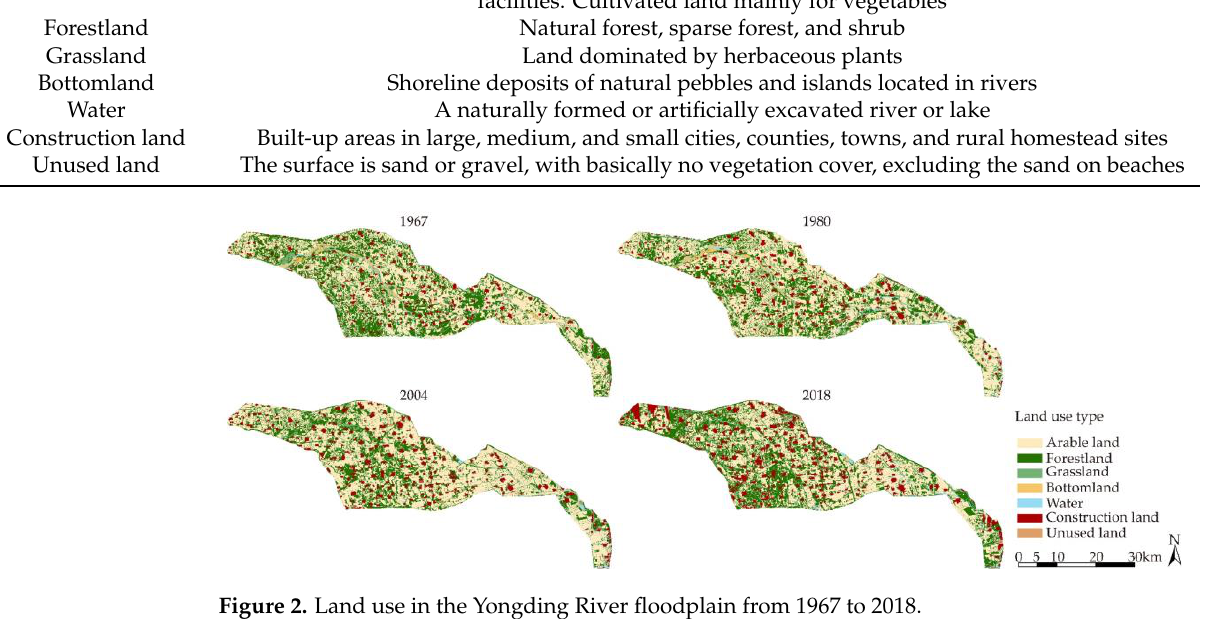
Table 2. Land use classification of the Yongding River floodplain.